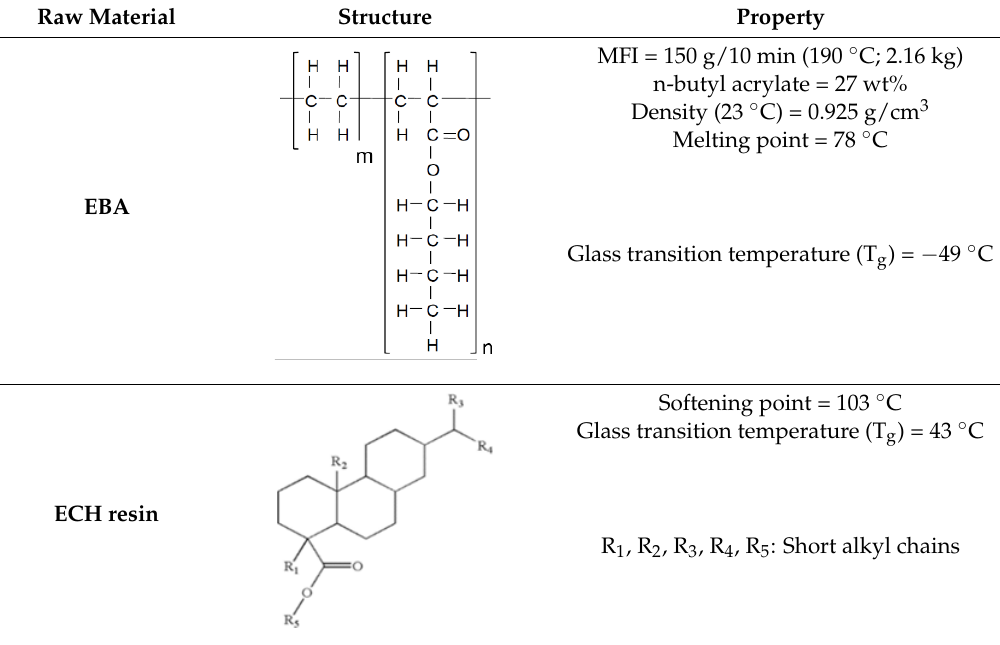
Table 1. Nomenclature, chemical structure, and some characteristics of the raw materials. Raw Material